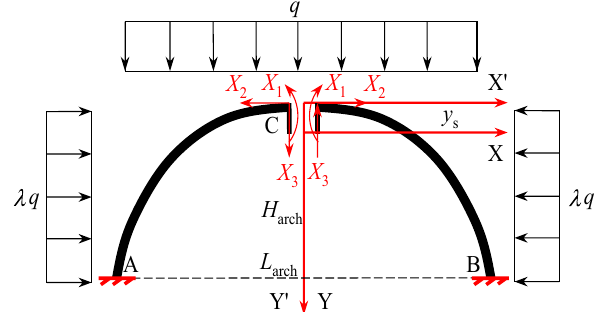
Figure 3. Mechanical model of the